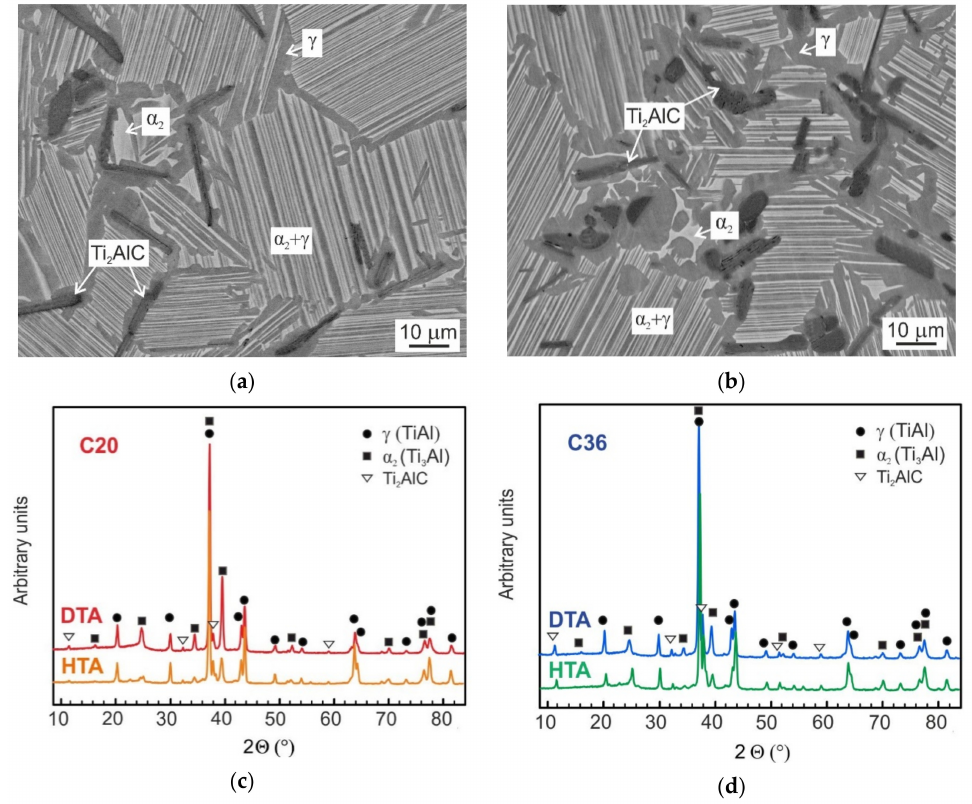
Figure 1. Microstructure and phase composition of DTA samples from C20 and C36 alloys after cooling from a temperature of 1450 ◦ C at a rate of 15 ◦ C / min: ( a ) BSE micrograph showing the microstructure of C20 alloy; ( b ) BSE micrograph showing the microstructure of C36 alloy; ( c ) The typical XRD patterns of C20 alloy; ( d ) The typical XRD patterns of C36 alloy. Table 2. Chemical composition of coexisting phases and regions of the studied alloys (at.%). Alloy Phases Ti Al